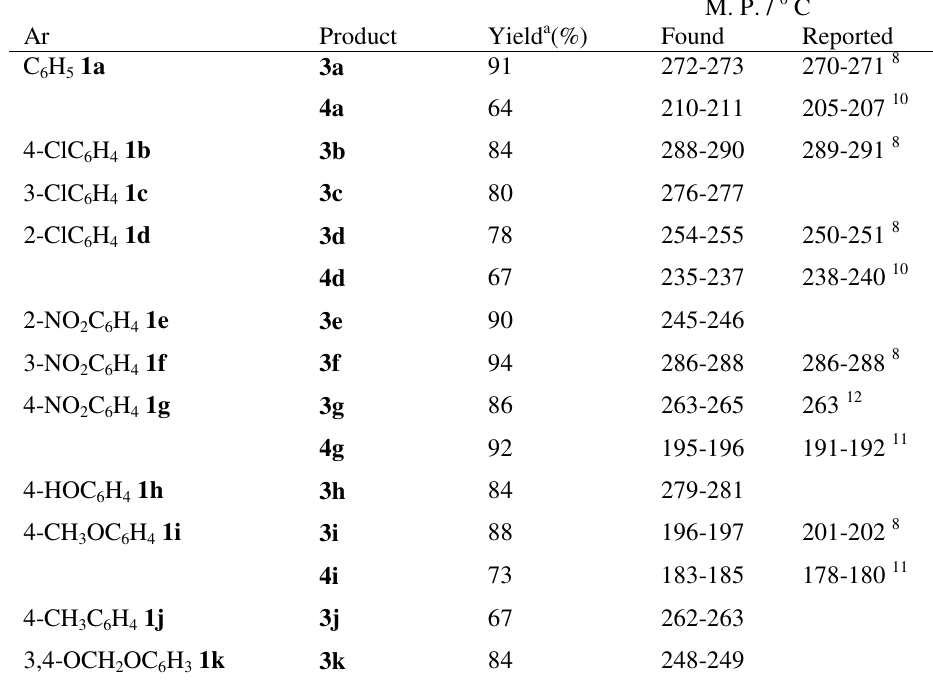
Table 1 Synthesis of 9-aryl-1,8-dioxooctahydroxanthene derivatives and 2,2’-aryl- methylene bis(3-hydroxy-2-cyclohexene-1-one) in aqueous media